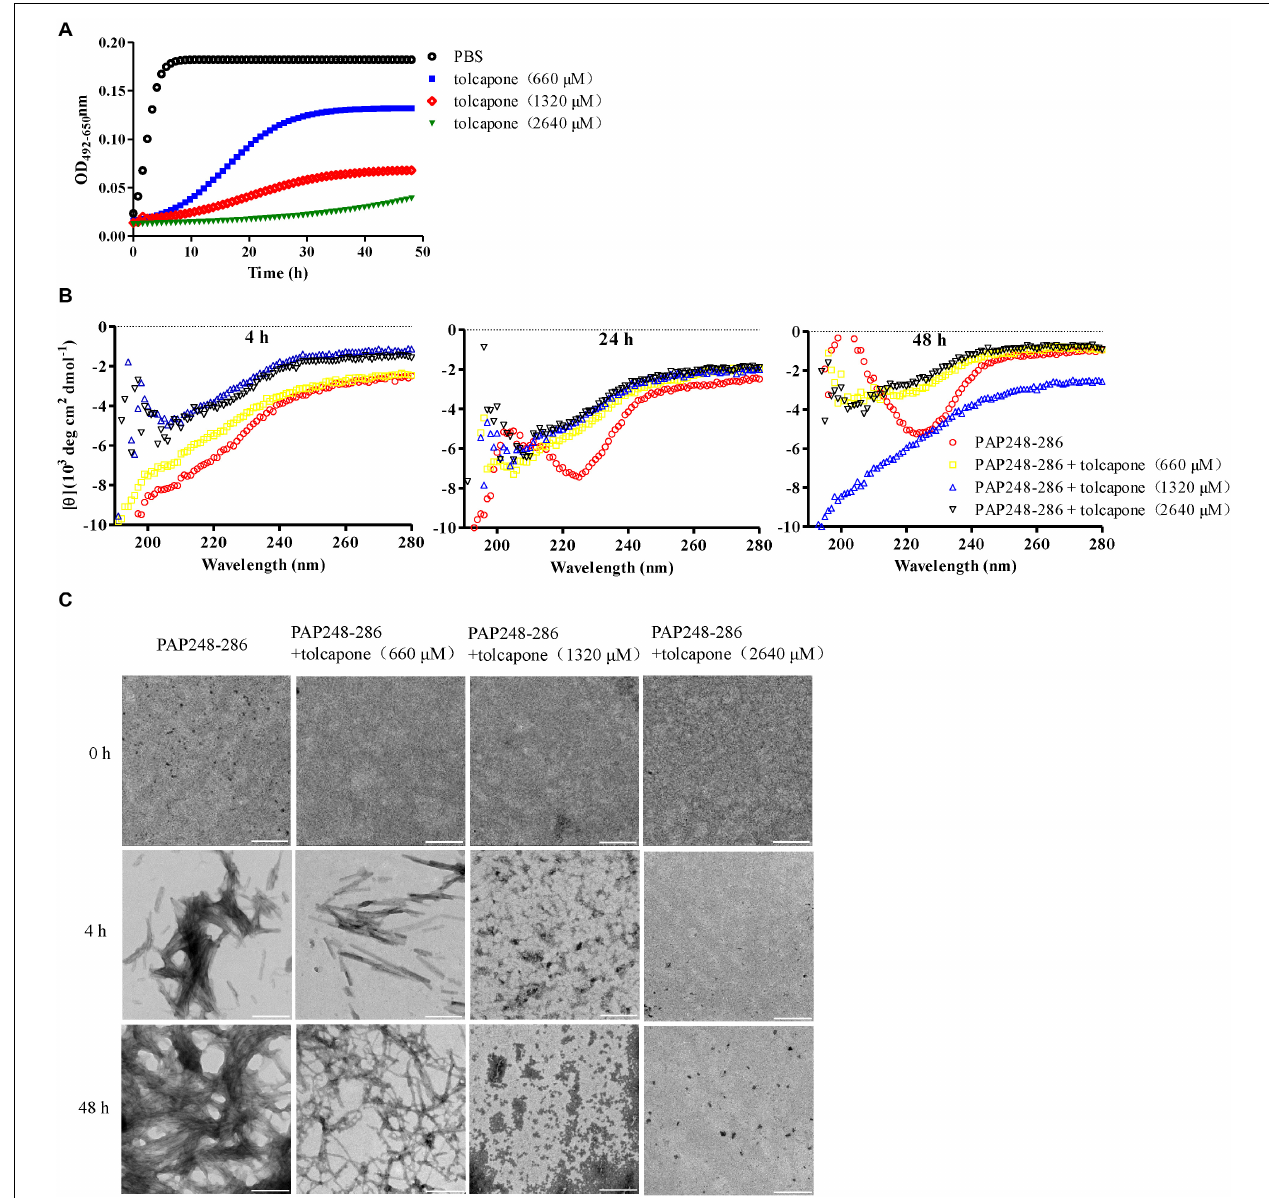
FIGURE 1 | Tolcapone inhibits the assembly of semen-derived enhancer of viral infection (SEVI) amyloid fibrils. (A) PAP248–286 (220 µ M) was incubated with tolcapone (660, 1320, 2640 µ M), and the mixture was agitated at 1,400 rpm at 37 ◦ C. Fibril formation was detected by Congo red staining at the indicated time points (0, 2, 4, 8, 12, 24, 48 h). The Congo red staining measurements were plotted as a function of time and fitted by a sigmoidal curve using Origin data analysis software to determine lag time ( t lag ). (B) β -Sheet formation of SEVI fibrils was monitored by circular dichroism (CD) spectroscopy at the time point of 4, 24, and 48 h. SEVI was tested at 66 µ M. The experiment was repeated once, and a similar result was obtained. (C) SEVI fibrils in the presence or absence of tolcapone at 0, 4, and 48 h were visualized by transmission electron microscopy (TEM). Scale bars indicate 200